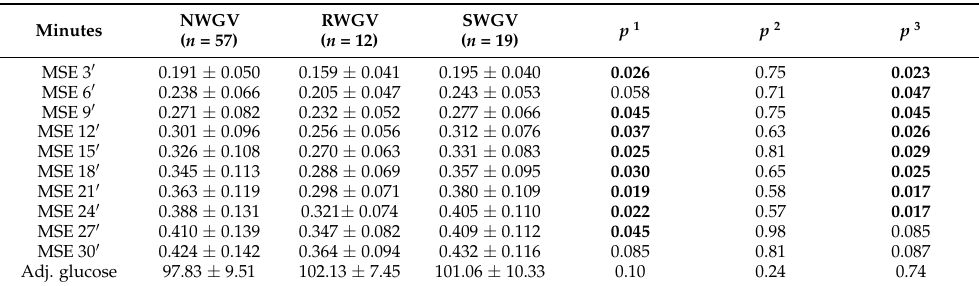
Table 5. MSE analysis in children considering growth velocity according to weight gain from birth to 6 months of age.